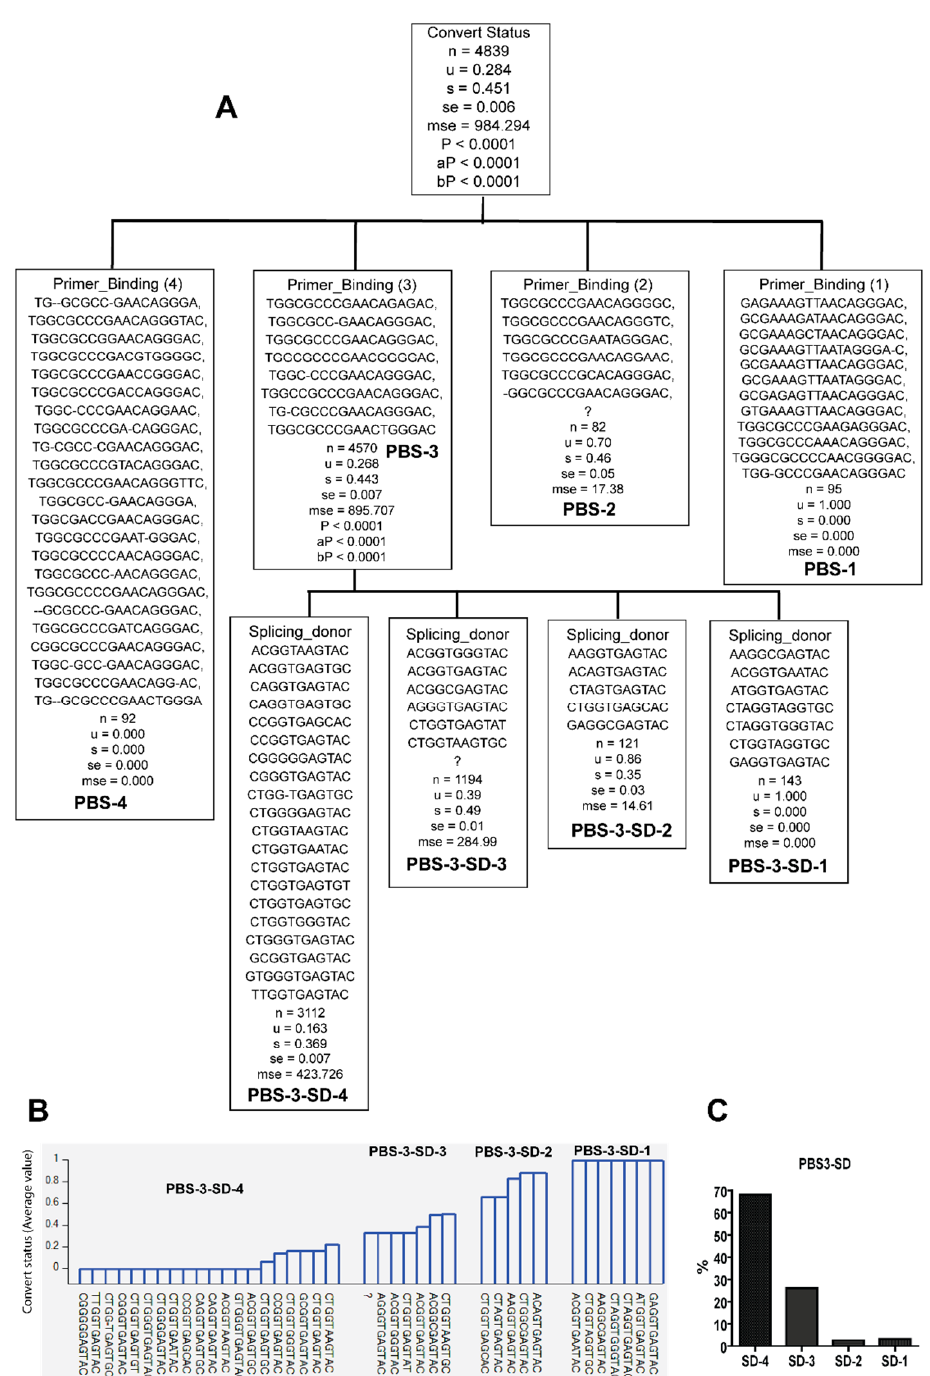
Figure 7. The combination of PBS variants (PBS-3) and splicing donor sequences identified only in either late ( u = 1) or early seroconverters ( u = 0). ( A ) PBS sequence variants in tree node of PBS-3 were further classified with SD sequence variants based on whether they were identified from late or early seroconverters. ( B ) The figure shows u value of sequence combinations based on whether the PBS–SD combinations were identified from late (1) or early (0) seroconverters. Note: n— counts (clone); u— mean value; s—standard deviation; se—standard error; mse—mean square error; p—p value; aP—adjusted p value; bP—Bonferroni corrected p value. ( C ) PBS3–SD variants frequencies. “?” denotes: lack of sequences”.